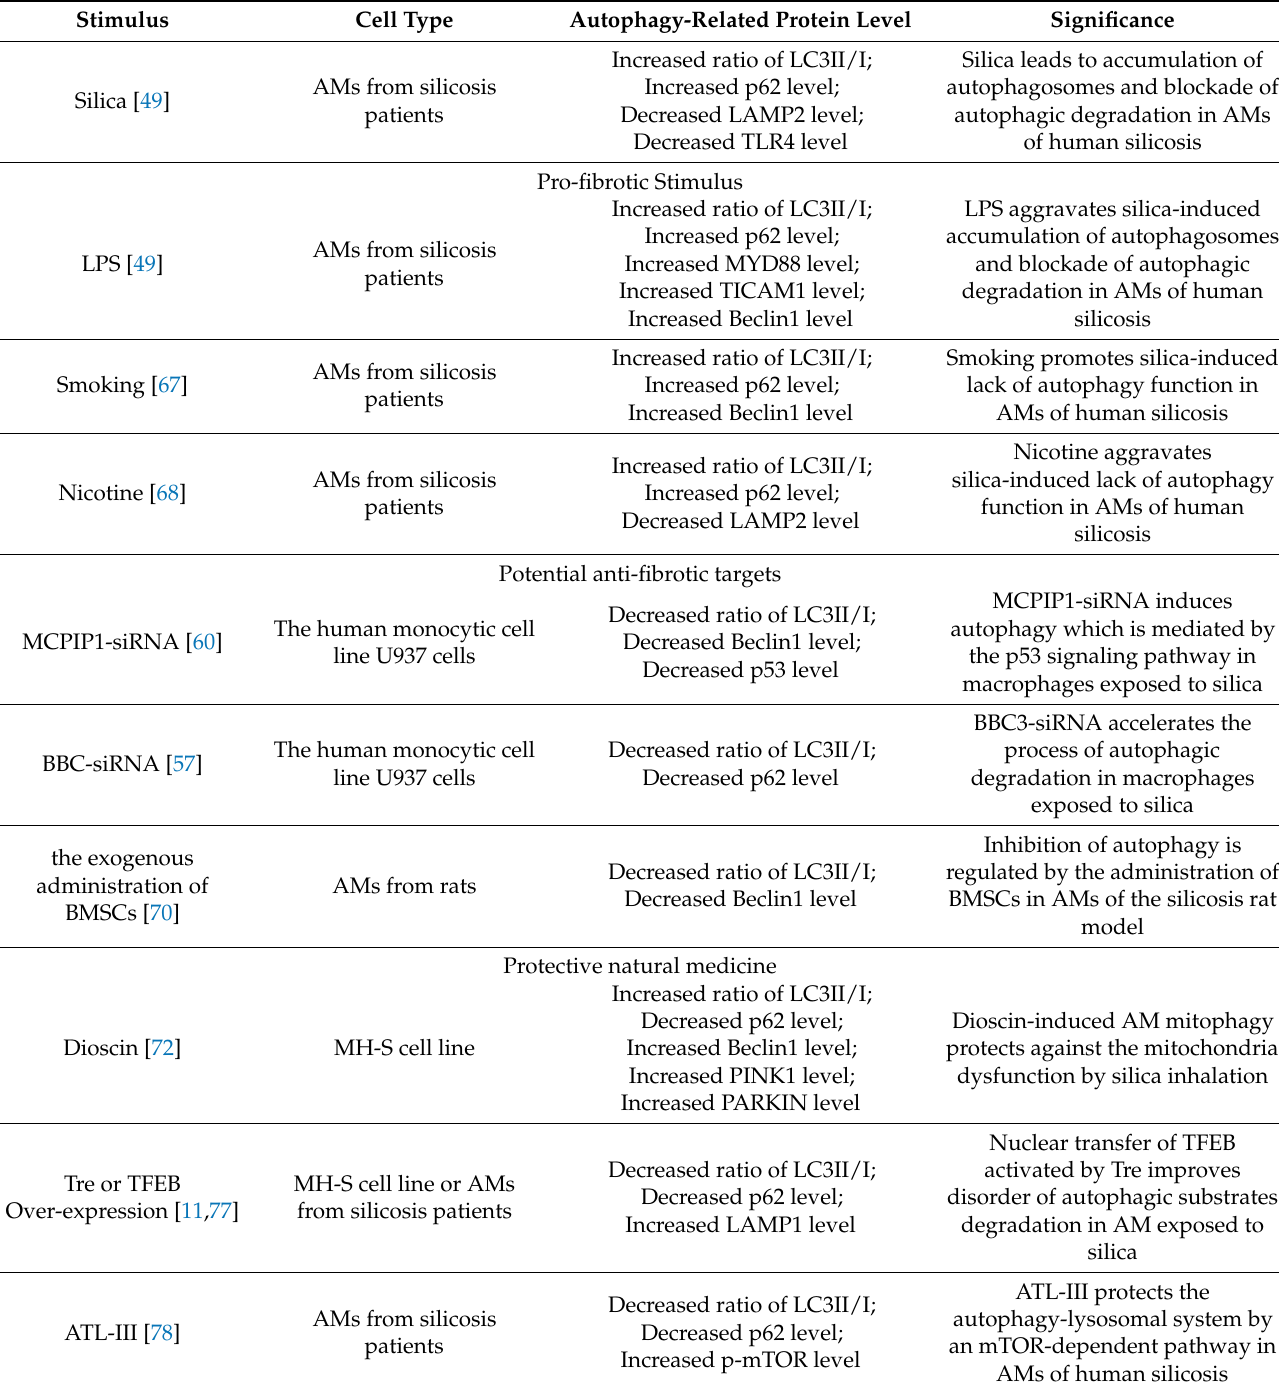
Table 2. Several potential autophagy-related targets in silica-induced pulmonary